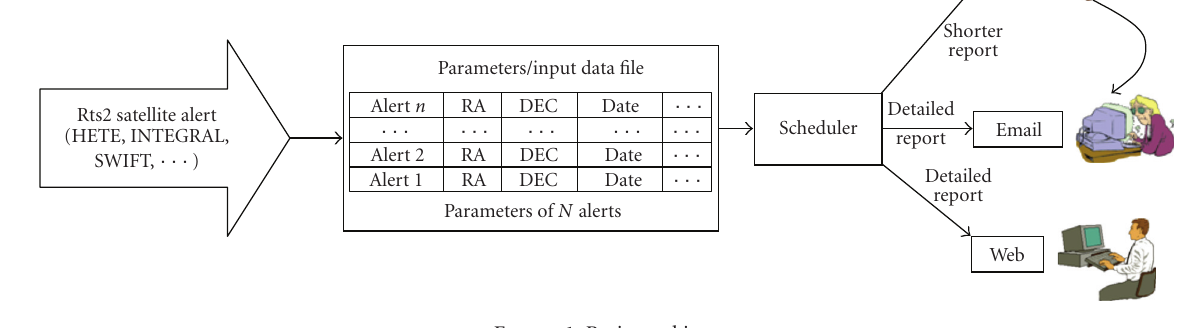
Figure 1: Basic working.